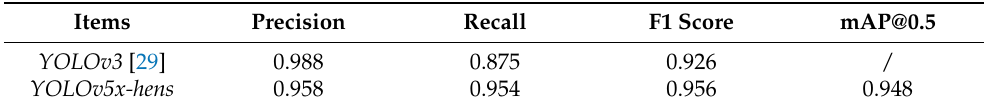
Table 2. Performance metrics for YOLOv5x-hens and the